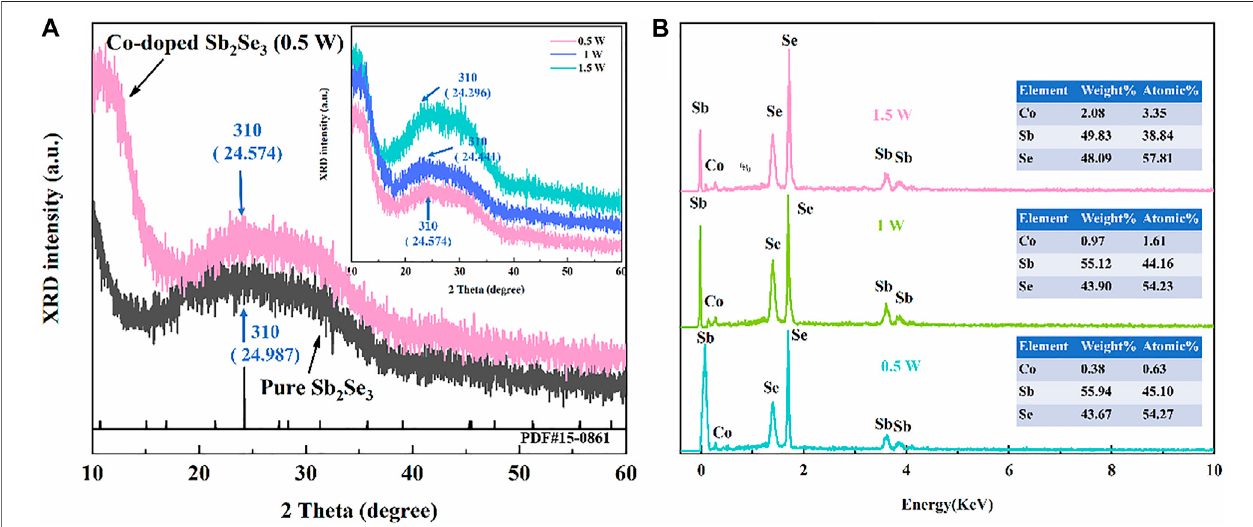
FIGURE 2 | (A) The XRD patterns of Co-doped and pure Sb 2 Se 3 nano fi lms. (B) The EDS of Co-doped Sb 2 Se 3 .